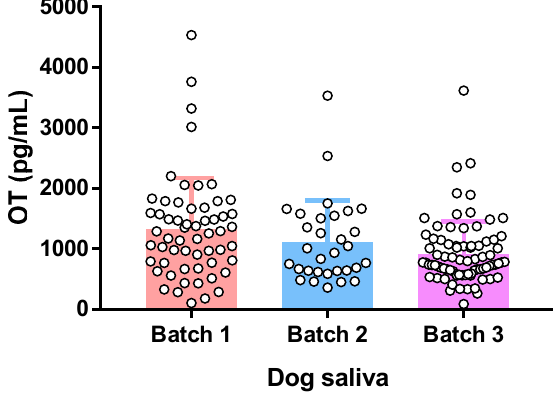
Figure 3. OT concentrations in dog saliva samples. Each batch contains 30–80 individual saliva samples. Data are represented as mean ± SD.